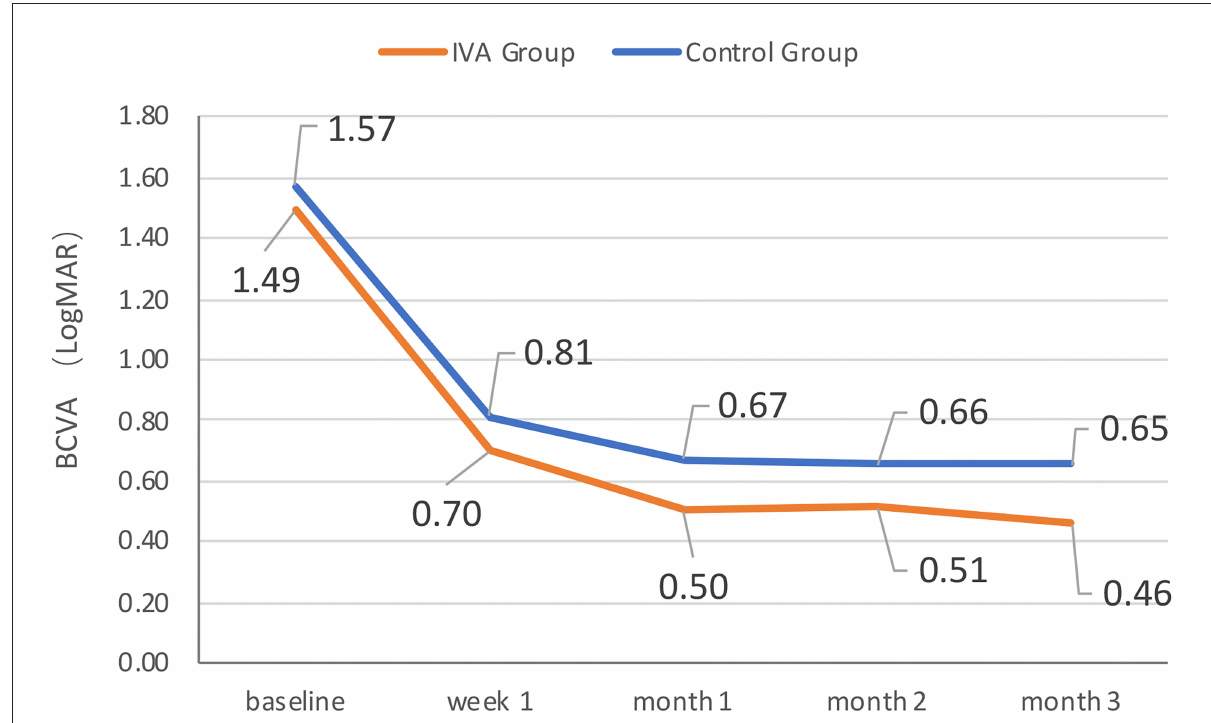
FIGURE2 The mean best-corrected visual acuity (BCVA) at each visit in the two groups. The mean BCVA in logMAR (Logarithm of the Minimum Angle of Resolution) scale at baseline, week 1, month 1, month 2, and month 3 after surgery in the preoperative intravitreal aflibercept (IVA) injection group and control